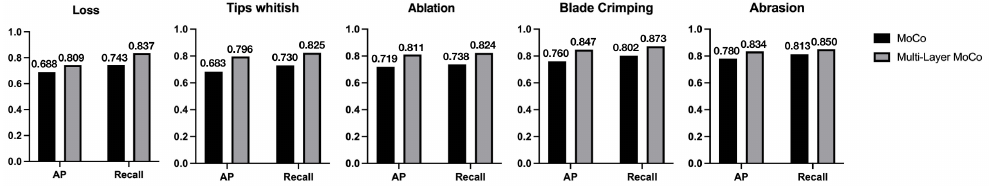
Figure 9. Comparison of experimental results between the multi-layer MoCo method and the MoCo method for the air compressor/turbine blades